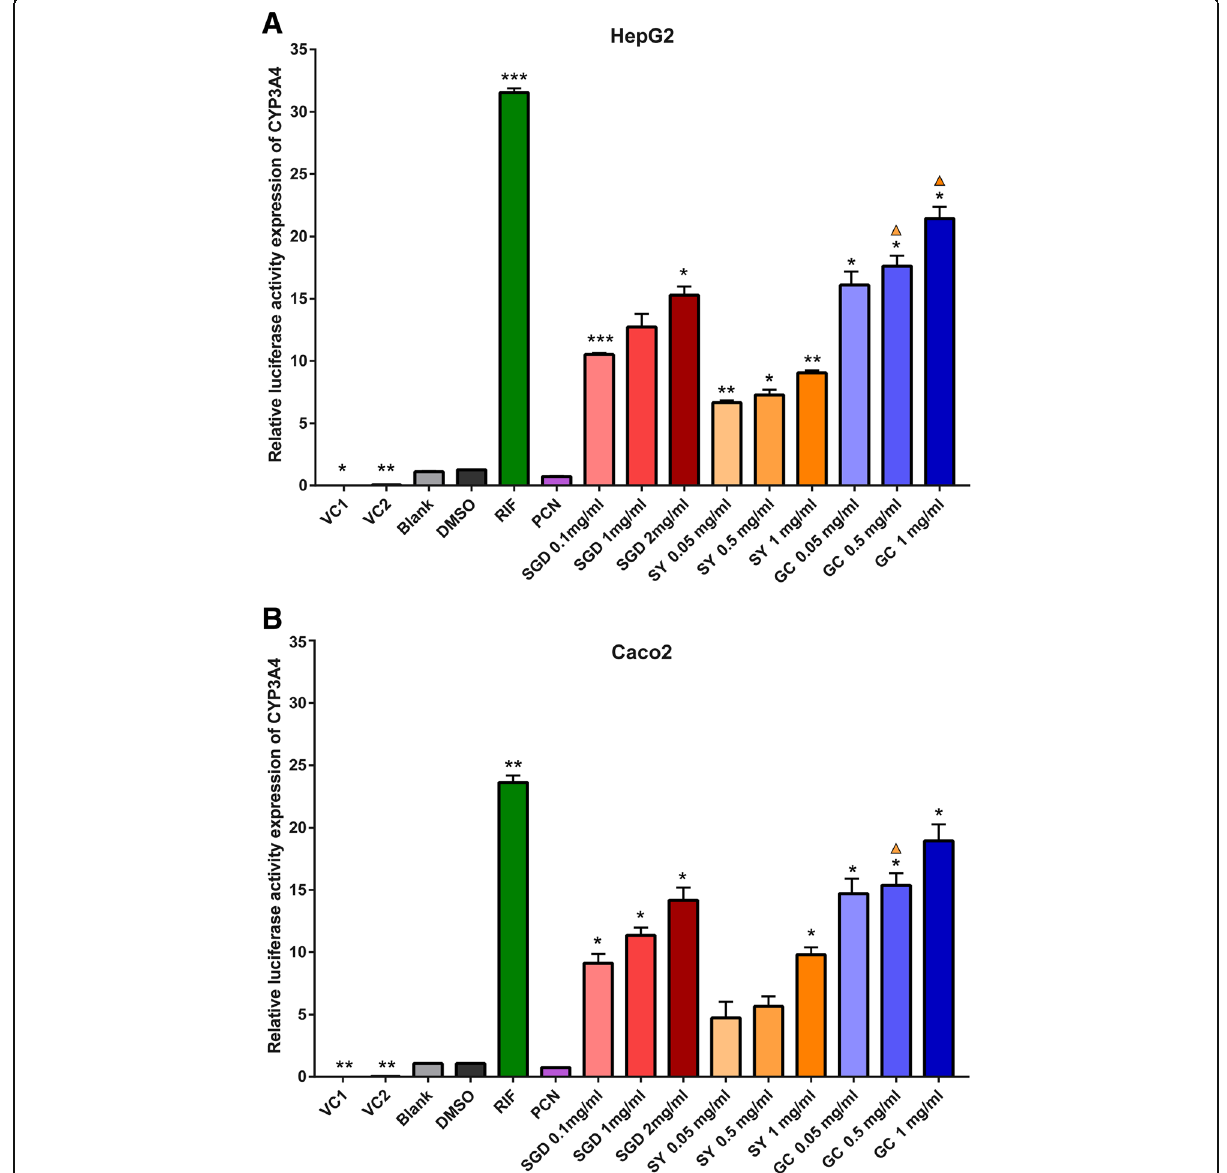
Fig. 3 Induced effects of CYP3A4 promoter mediated via PXR by SGD, SY and GC in HepG2 ( a ) and Caco2 ( b ). There is a significant increase in positive control RIF group and most prescriptions groups when compared with 0.1% DMSO treatment group ( p <0.05). There is no significant decrease in negative control PCN group when compared to the DMSO group ( p >0.05). VC1: cells were transfected with pcDNA3.1-PXR, PRL-SV40, pGL4.17; VC2: cells were transfected with pcDNA3.1, PRL-SV40, pGL4.17-CYP3A4; other groups: cells were transiently transfected with pcDNA3.1-PXR, PRL-SV40, pGL4.17- CYP3A4. All data were obtained from three independent experiments performed by triplicate and expressed as mean±S.E.M. Statistical significance was determined by one-way ANOVA with Welch correction, followed by the Games Howell test for pairwise comparisons. One-way ANOVA with Welch ’ s correction revealed significant differences among the groups (Welch ’ s p <0.001). * p <0.05, ** p <0.01, *** p <0.001 compared with the DMSO group; ▲ p < 0.05 represents GC group compared to SY group with the same